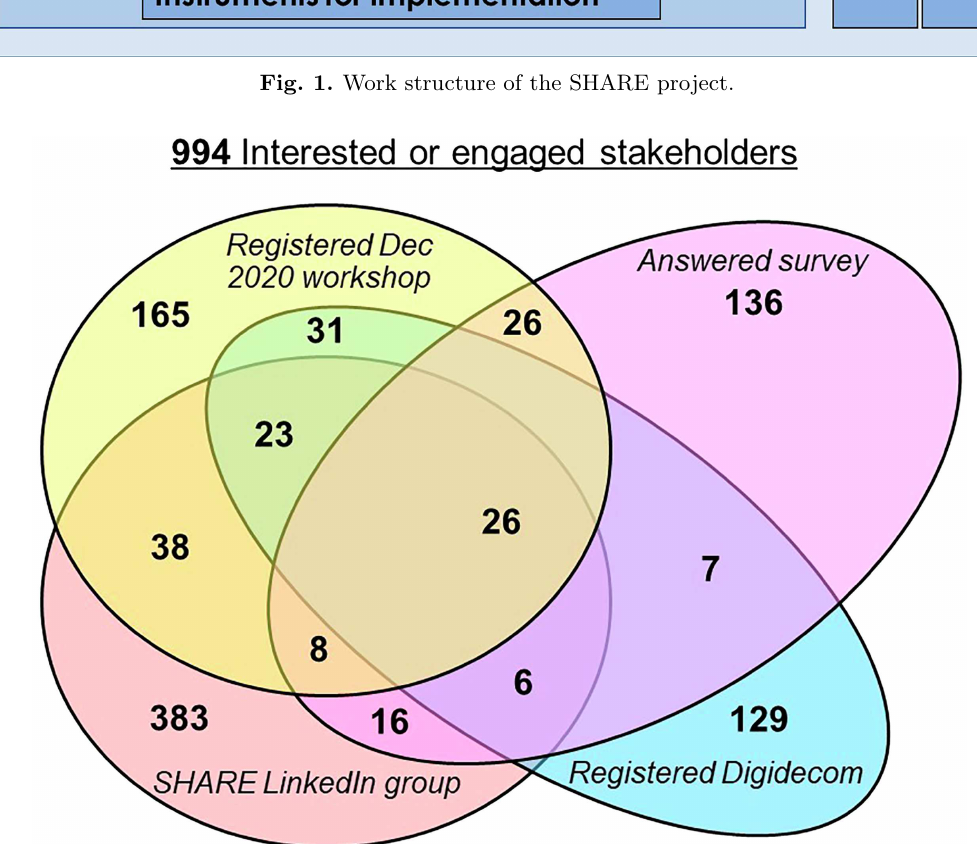
Fig. 2. Overview of the number of Stakeholder that engaged in or followed the